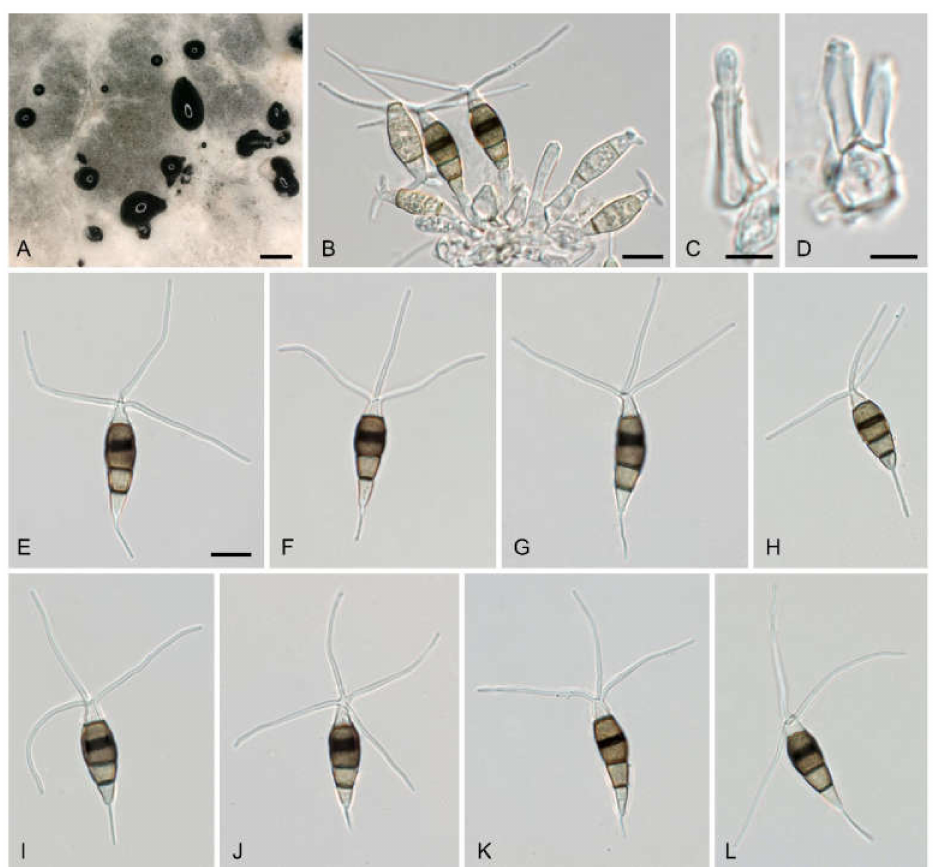
Figure 9. Neopestalotiopsis siciliana ( A – G , I – L ) strain AC46, holotype; ( H ) strain AC48). ( A ) PDA culture with sporodochial conidiomata and drops of black conidial masses; ( B ) conidiogenous cells giving rise to conidia; ( C , D ) holoblastic-annelidic conidiogenous cells; ( E – L ) conidia. All in tap water. Scale bars: ( A ) = 1 mm; ( B , E – L ) = 10 µ m, ( C , D ) = 5 µ m. Etymology . Named after the region where it was found